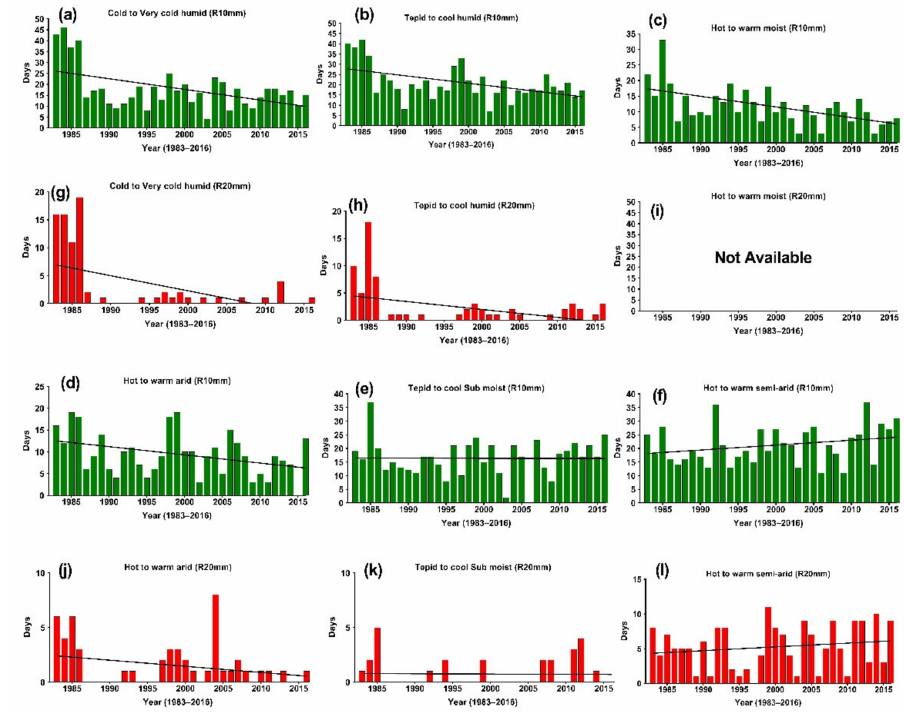
Figure 10. Number of heavy (R10mm) ( a – f ) and very heavy (R20mm) ( g – l ) precipitation days over agroecological zones for the period